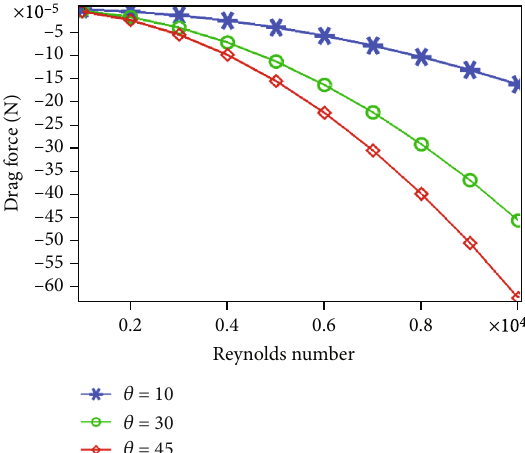
Figure 8: The drag force ( N ) is calculated at the screen for all Reynolds number with the angles 10 ° , 30 ° , and 45 °